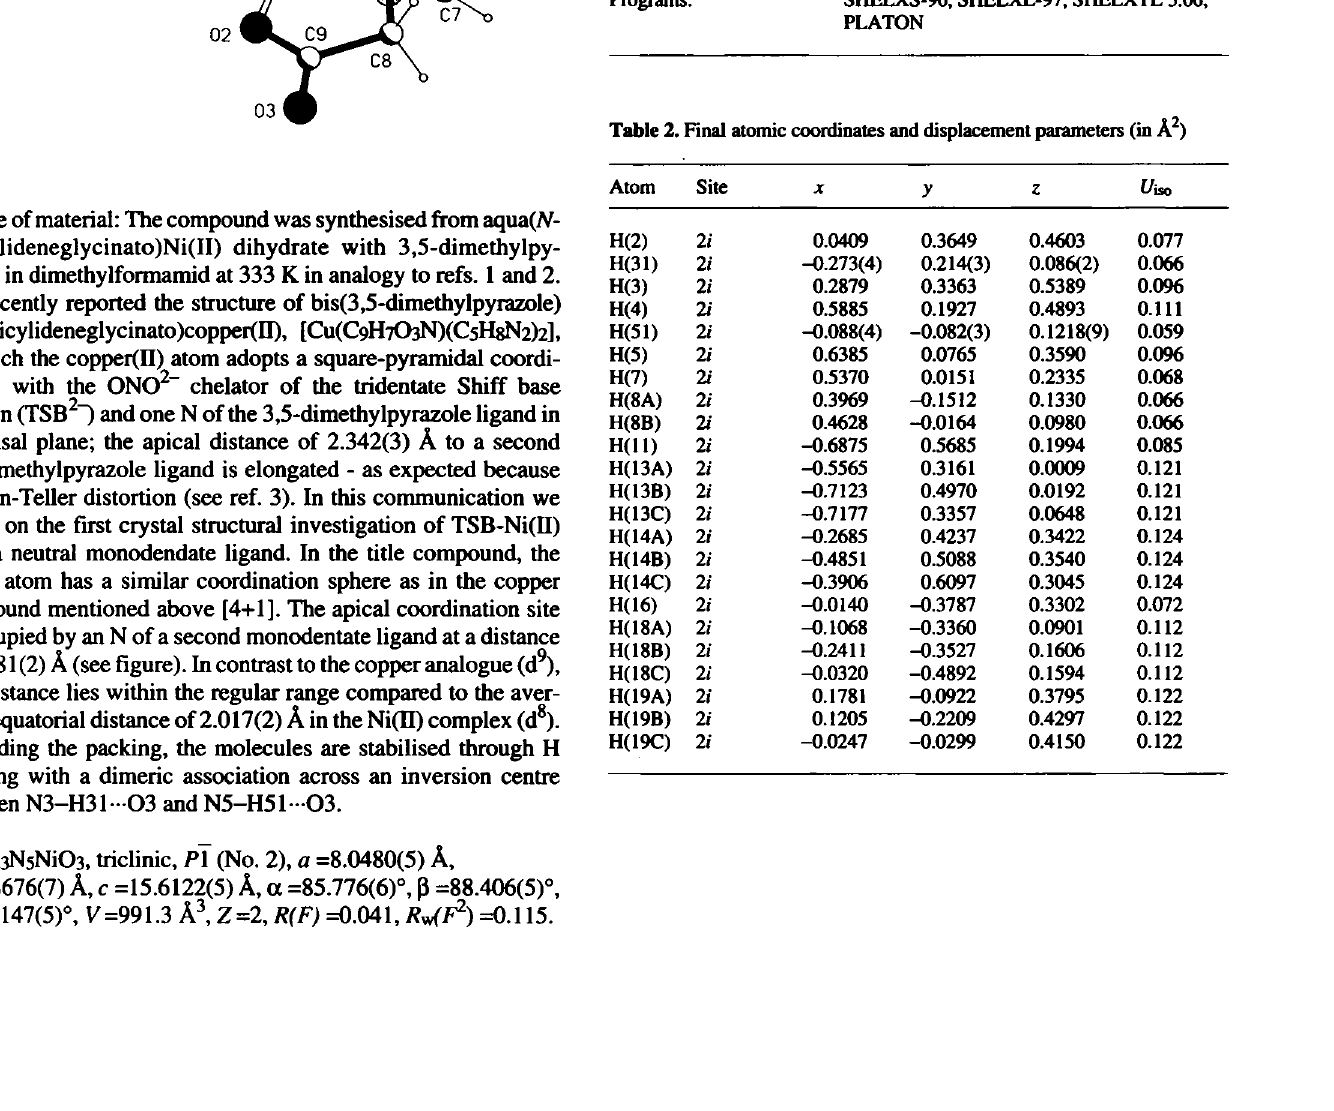
Table 2. Final atomic coordinates and displacement parameters (in